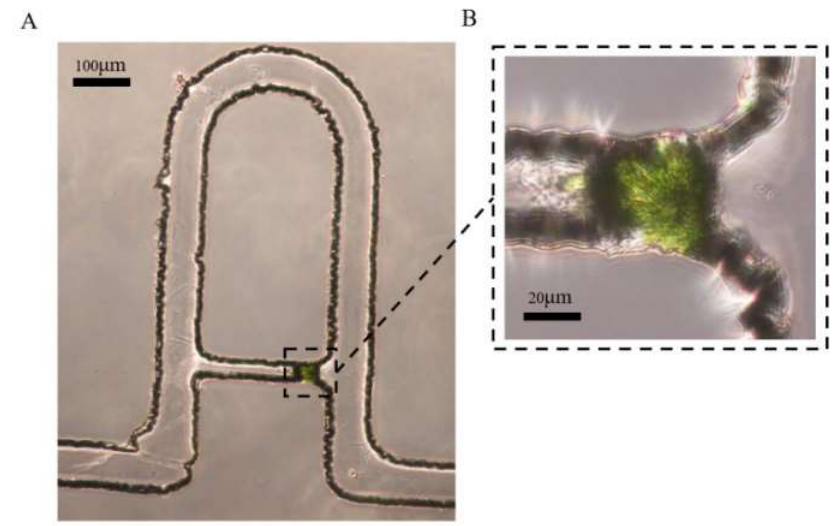
Figure 6. ( A ) Enlarged microscopic image of one single tobacco protoplast trapped. ( B ) Partial enlargement of figure A.